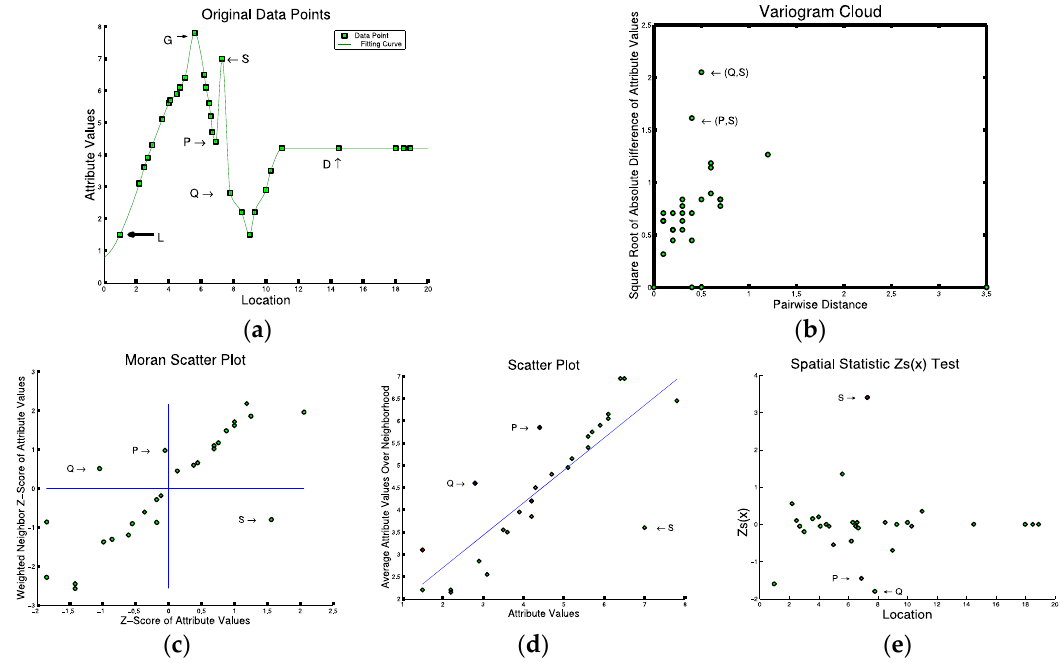
Figure 5. Examples of spatial statistics for spatial outlier detection [62]. ( a ) Original input data points; ( b ) Spatial outliers found by variogram cloud; ( c ) Spatial outliers found by Moran scatter plot; ( d ) Spatial outliers found by scatter plot; ( e ) Spatial outliers found by spatial statistic test.